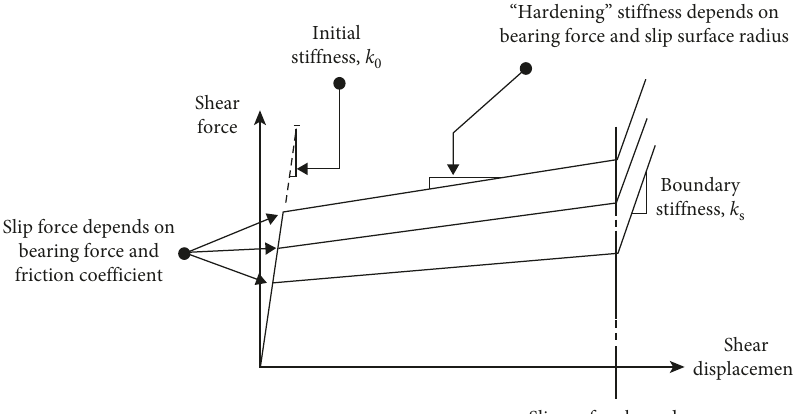
Figure 10: Behavior of friction-pendulum element.